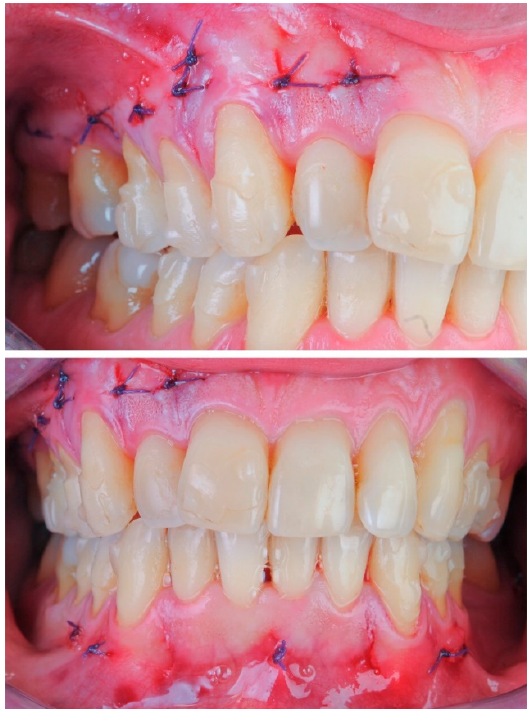
Figure 19. Case 2: photographs after the surgical procedure; sutures with Vicryl 5.0 thread were applied only where bleeding persisted.